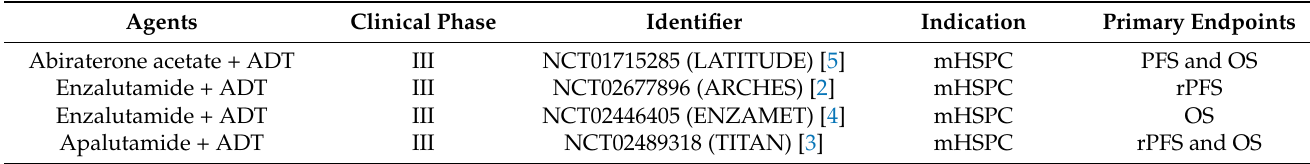
Table 2. Clinical trials evaluating androgen receptor inhibitor therapy for